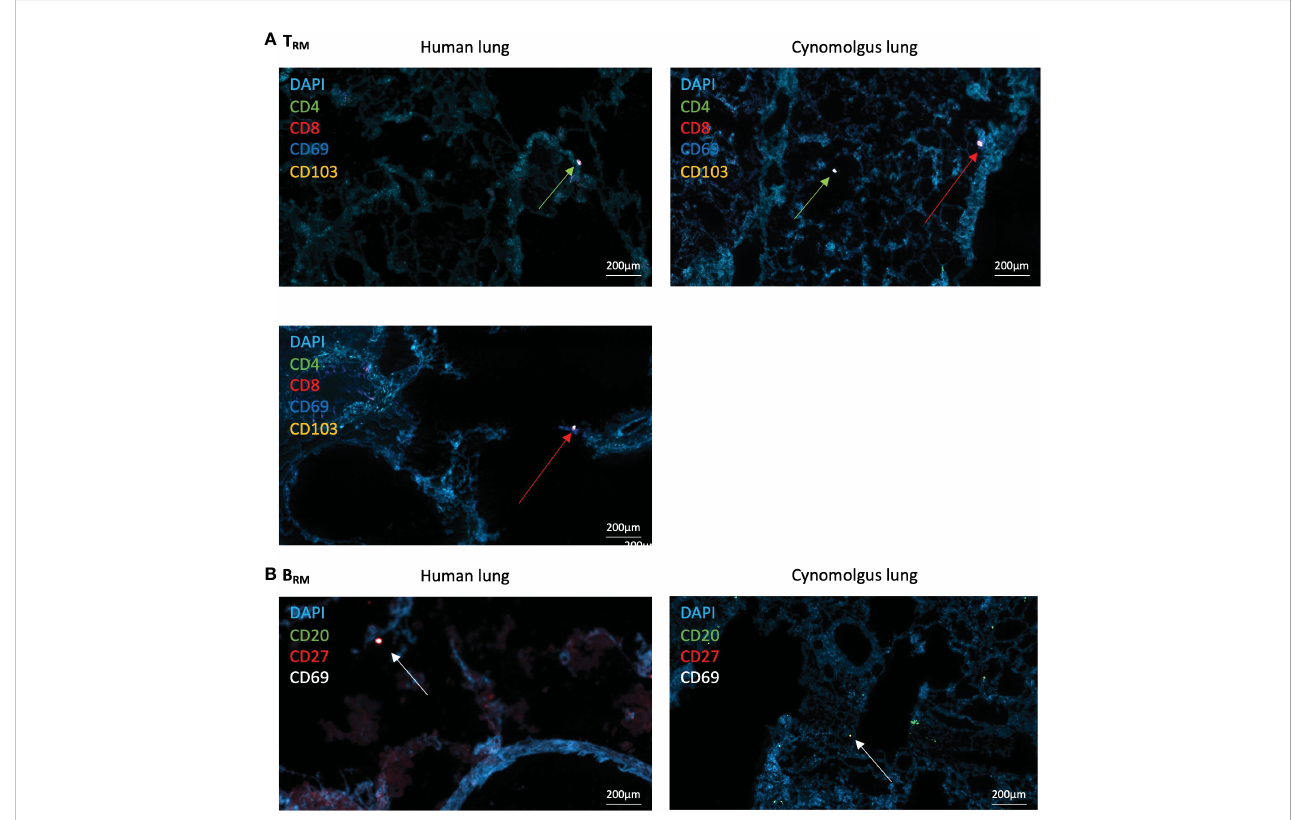
FIGURE 3 Human and NHP Immuno fl uorescence T RM /B RM Detection. Frozen lung sections or BAL cells were stained using tyramide signal ampli fi cation. (A) Human and NHP T RM detection in lung. CD4 + and CD8 + T RM were detected based on their expression of CD69 and CD103. (B) Human and NHP B RM detection in lung. B RM were detected based on their expression of CD20, CD27 and CD69. Images taken at x400 magni fi cation. Green arrows represent CD4 + T RM and red arrows represent CD8 + T RM (A) , and white arrows represent B RM (B)